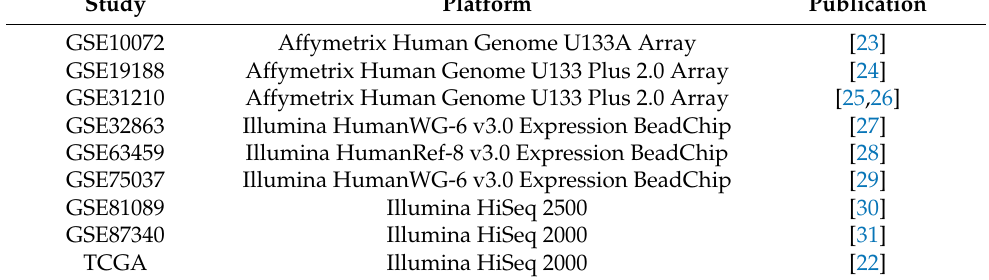
Table 1. Studies selected after the systematic review.